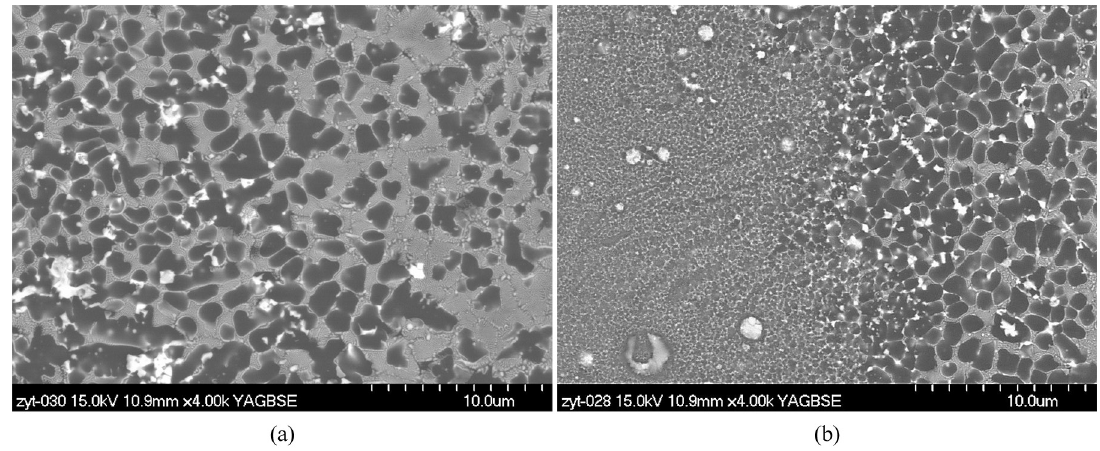
Figure 6. Back scattering electron images of (a) cellular structure and (b) nano and cellular structure of the Al